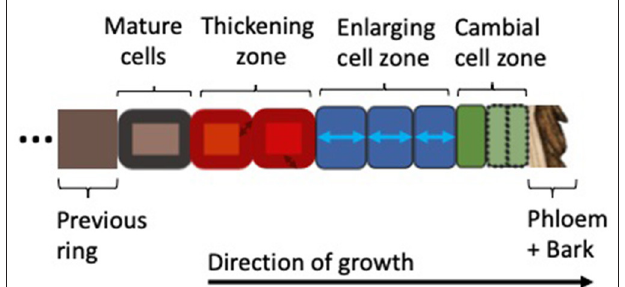
FIGURE 1 | Xylogenesis along a single radial file of developing cells, showing the zones of cell division, enlargement, wall thickening, and mature (dead) cells (Plomion et al., 2001; Fromm, 2013; Rathgeber et al., 2016). Depending on their different stages of development, the cells are assumed to be under varying environmental constraints and tree-internal regulation. Wood formation models covered in this review follow this schema and resolve one or more cell types with their associated